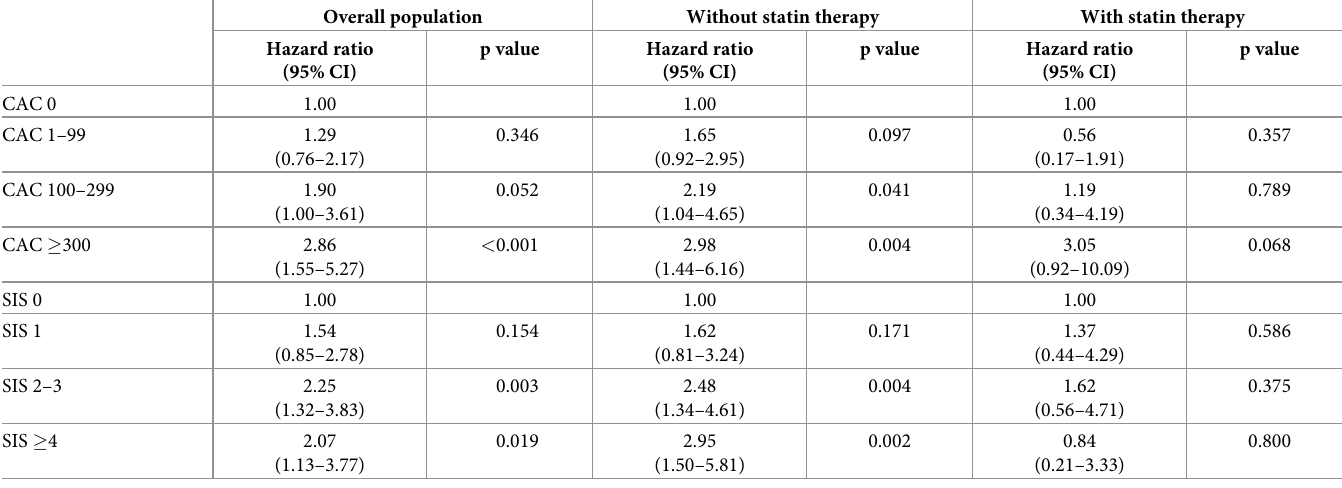
patients with SIS > 1 was associated with higher risk of all-cause mortality (p < 0.05). This asso- ciation was influenced by the presence of baseline statin therapy (Fig 2, Table 3). Relative to those with SIS = 0 not taking baseline statins, the adjusted risk of all-cause mortality increased stepwise with increasing SIS, with significantly increased mortality hazard for SIS 2–3 and SIS � 4. Conversely, this stepwise association was attenuated by the presence of baseline statin therapy (p value for interaction = 0.007). An increased mortality hazard was not observed in patients with any degree of SIS on baseline statin therapy. Table 3. Adjusted association between all-cause mortality, CAC, SIS, and baseline statin therapy a